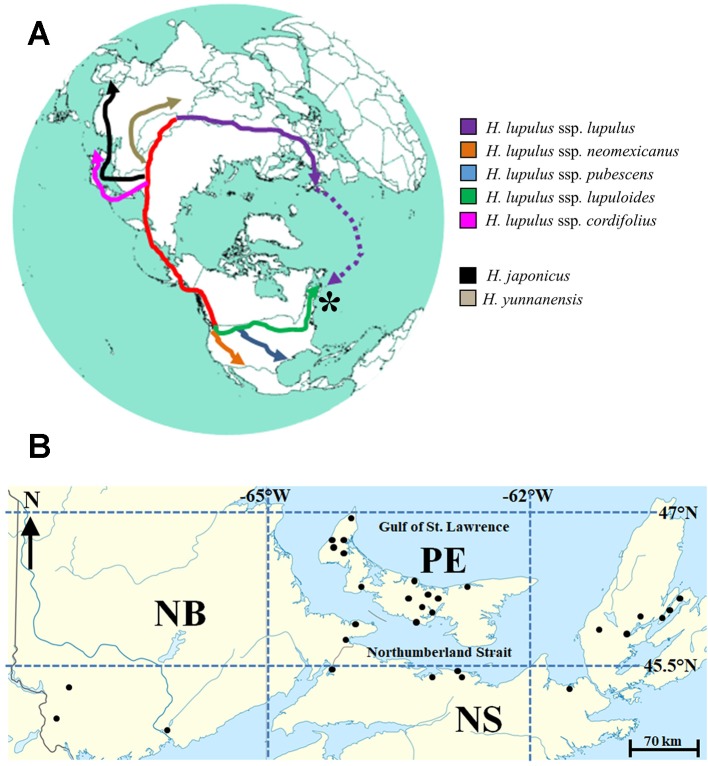

(A) Reconstructed circumpolar distribution of Humulus lupulus L., from purported central Asian origins. Migration and colonization of the Maritimes region of Canada (*) by H. lupulus ssp. lupuloides (green) possibly represents the farthest geographic divergence from the origin of species. Dotted purple line represents recent introduction via European colonization events, while red track represents ancient North American colonization route via Beringia. Presumed origins of related Humulus species are highly speculative. (B) Approximate locations for 30 wild-growing Maritimes hops accessions analyzed in this study. Site names and exact locations deliberately obscured to protect landowners. For further details, see
Table 2
 and body of text.